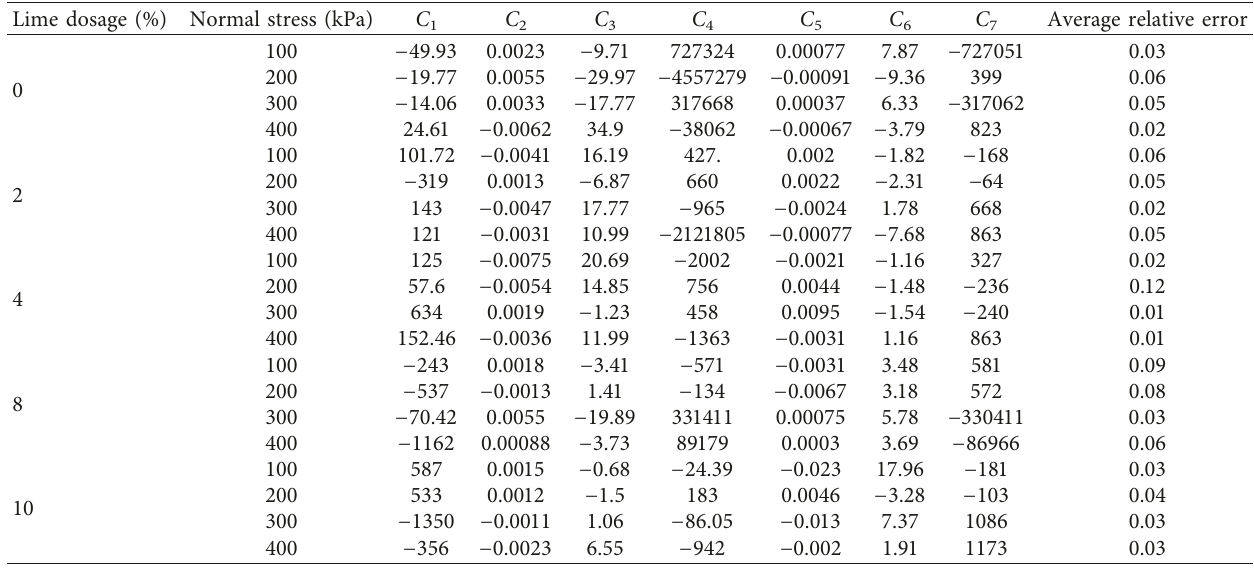
Figure 6: (a) Cohesion and (b) internal friction angle of iron tailing powder with different lime doses. Table 3: BP neural network fitting results.